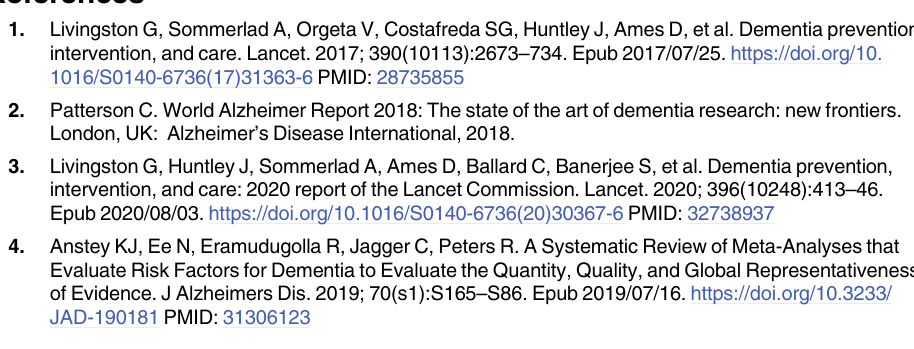
S1 Table. Individual study characteristics. S2 Table. All coded quotations and author